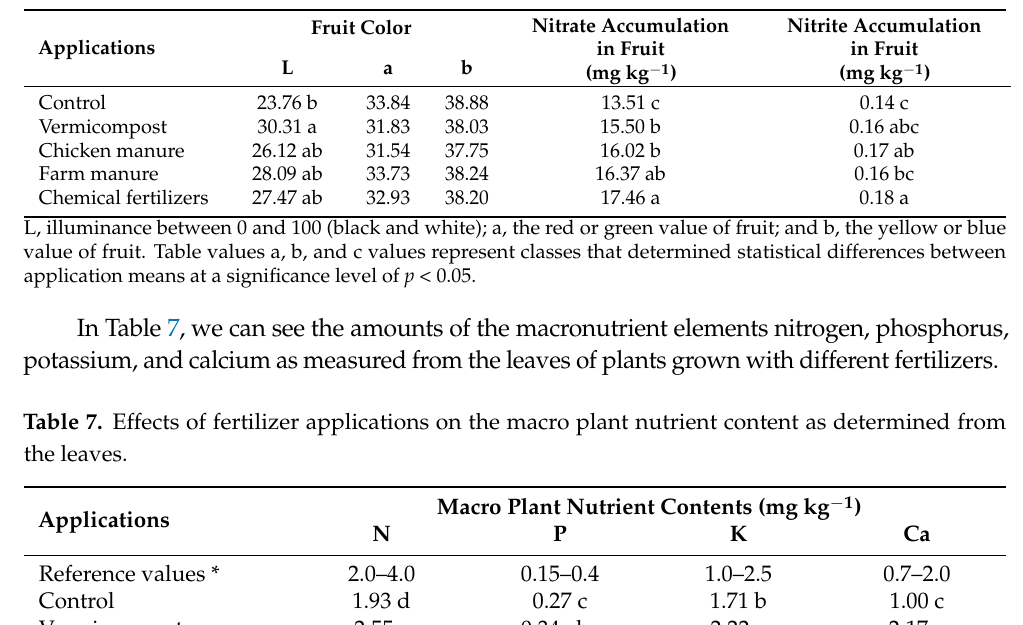
Table 6. Effects of fertilizer applications on L, a, and b color values and nitrate and nitrite accumula- tion in fruits.